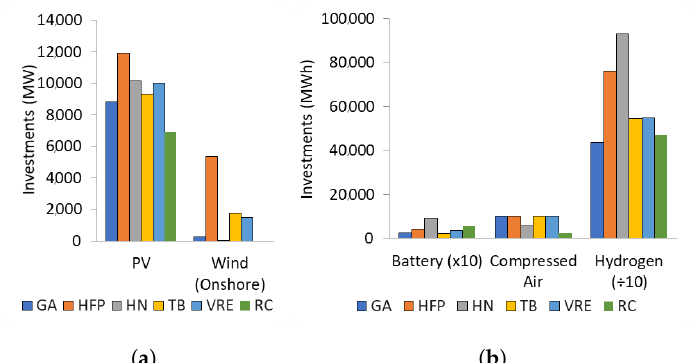
Figure 6. ( a ) 2040 investments in variable renewable generation. ( b ) 2040 investments in energy storage